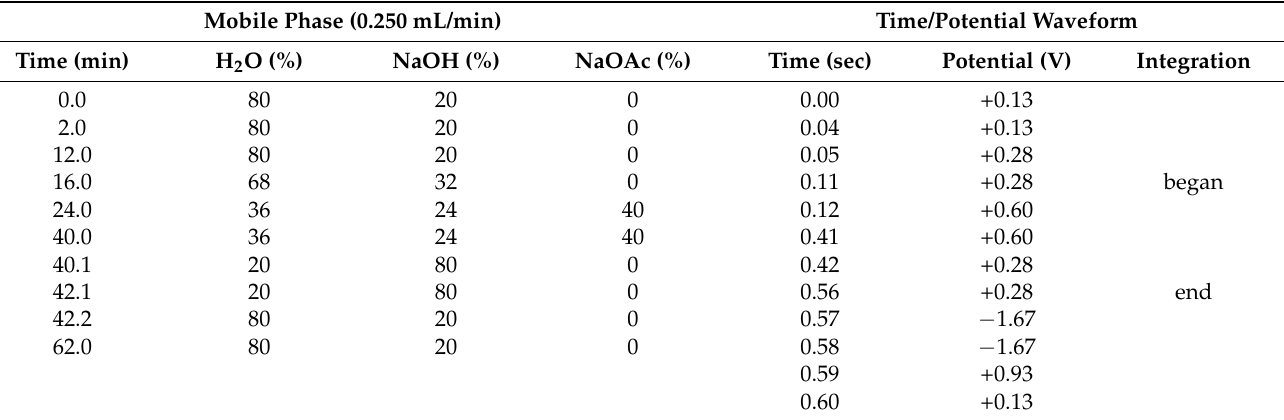
Table 2. Conditions for chromatographic separation of amino